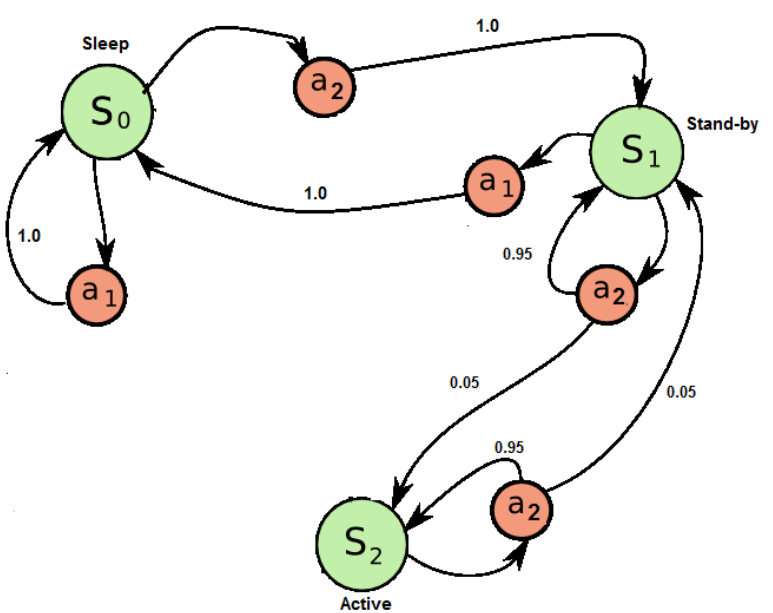
Figure 5. Three-state Markov Model for BS3.